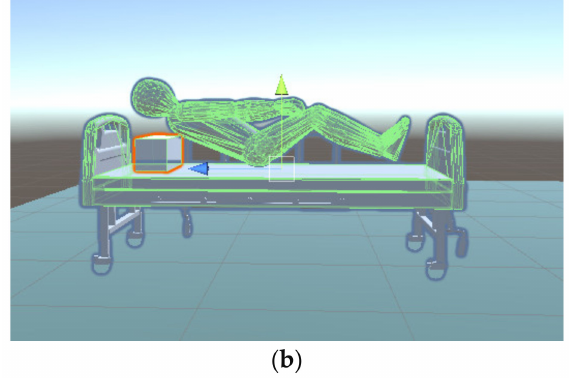
Figure 8. Collision detection configuration diagram. ( a ) Robot collision detection configuration. ( b ) Human body and bed collision detection configuration